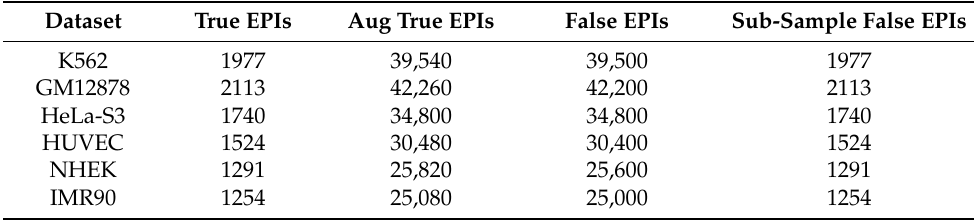
Table 1. The details of the balanced